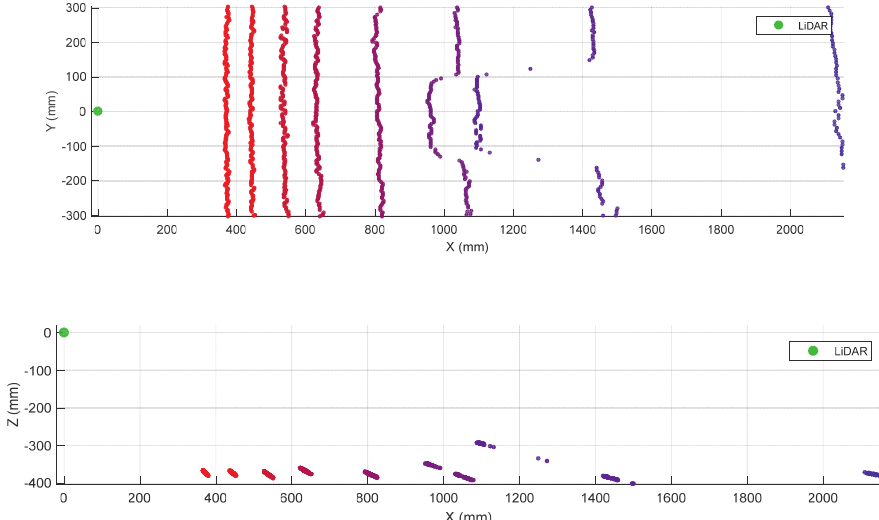
Figure 3. Top (up) and lateral (down) view of different scans obtained when placing a small box on the ground at approximately 1000 mm from the LIDAR. The height of the LIDAR was 380 mm and the tilt was changed from 45° (reddish ground line, close to X = 0) to 80° (violet ground line) in increments of 5°.